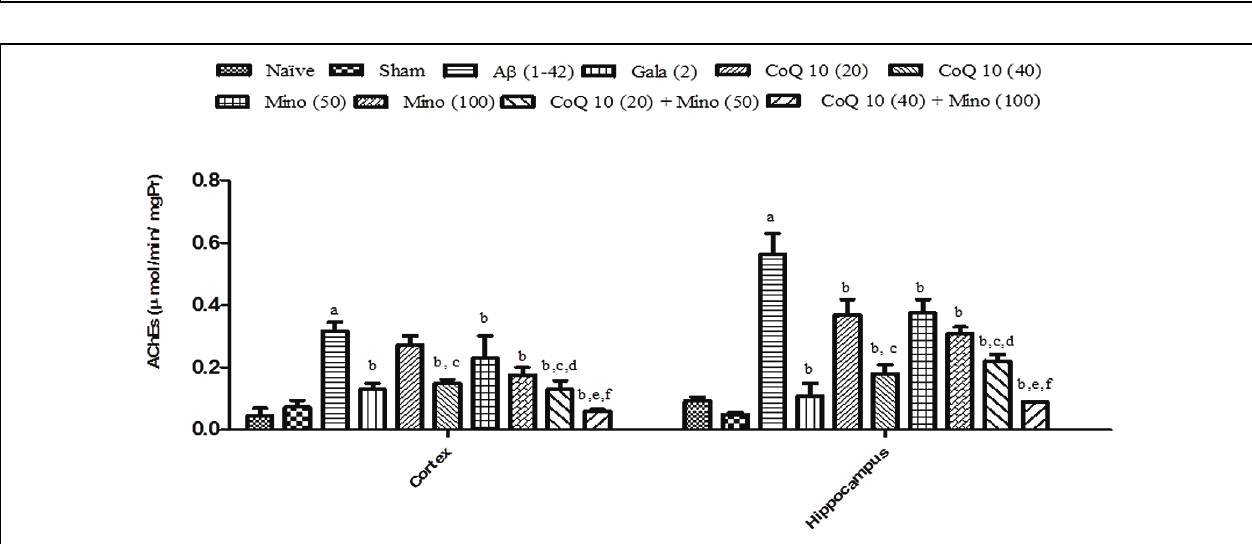
FIGURE 5 | Effect of CoQ10 and minocycline alone and in combination on AChE activity in the hippocampus and cortex region of A β (1-42) treated rats. Data expressed as mean ± SEM a P < 0.05 compared to sham group; b P < 0.05 compared to A β (1-42) treated group; c P < 0.05 compared to CoQ10 (20) group; d P < 0.05 compared to Mino (50) group; e P < 0.05 compared to CoQ10 (40); f P < 0.05 compared to Mino (100) group (One way ANOVA followed by Tukey’s test). (A β , Amyloid beta; Gala, Galantamine; CoQ10, Coenzyme Q 10; Mino, Minocycline; AChE,